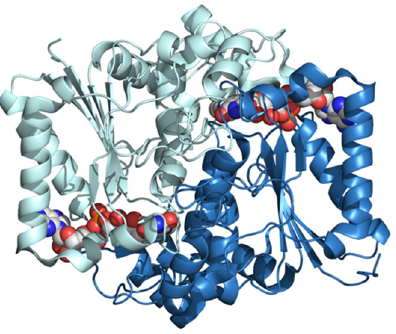
Figure 5. The 3D structure of human NQO1 determined by X-ray diffraction at 2.01 Å of resolution (pdb ID: 5ea2) [36]. The two subunits are shown in different colors. FAD bound to each subunit is shown in the CPK mode.